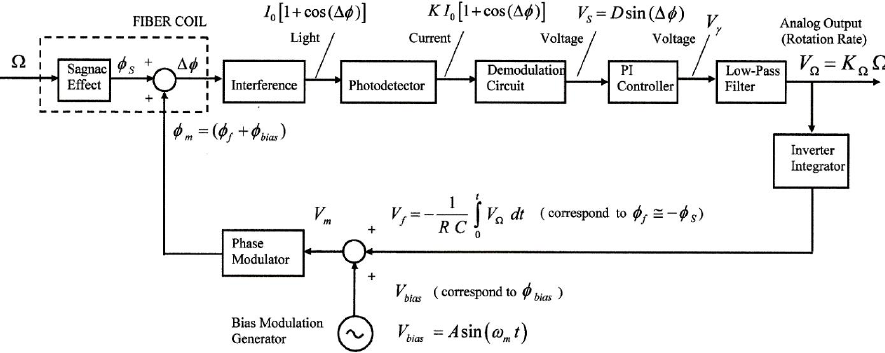
Figure 2. Analog closed-loop scheme for feedback phase-modulation configuration.